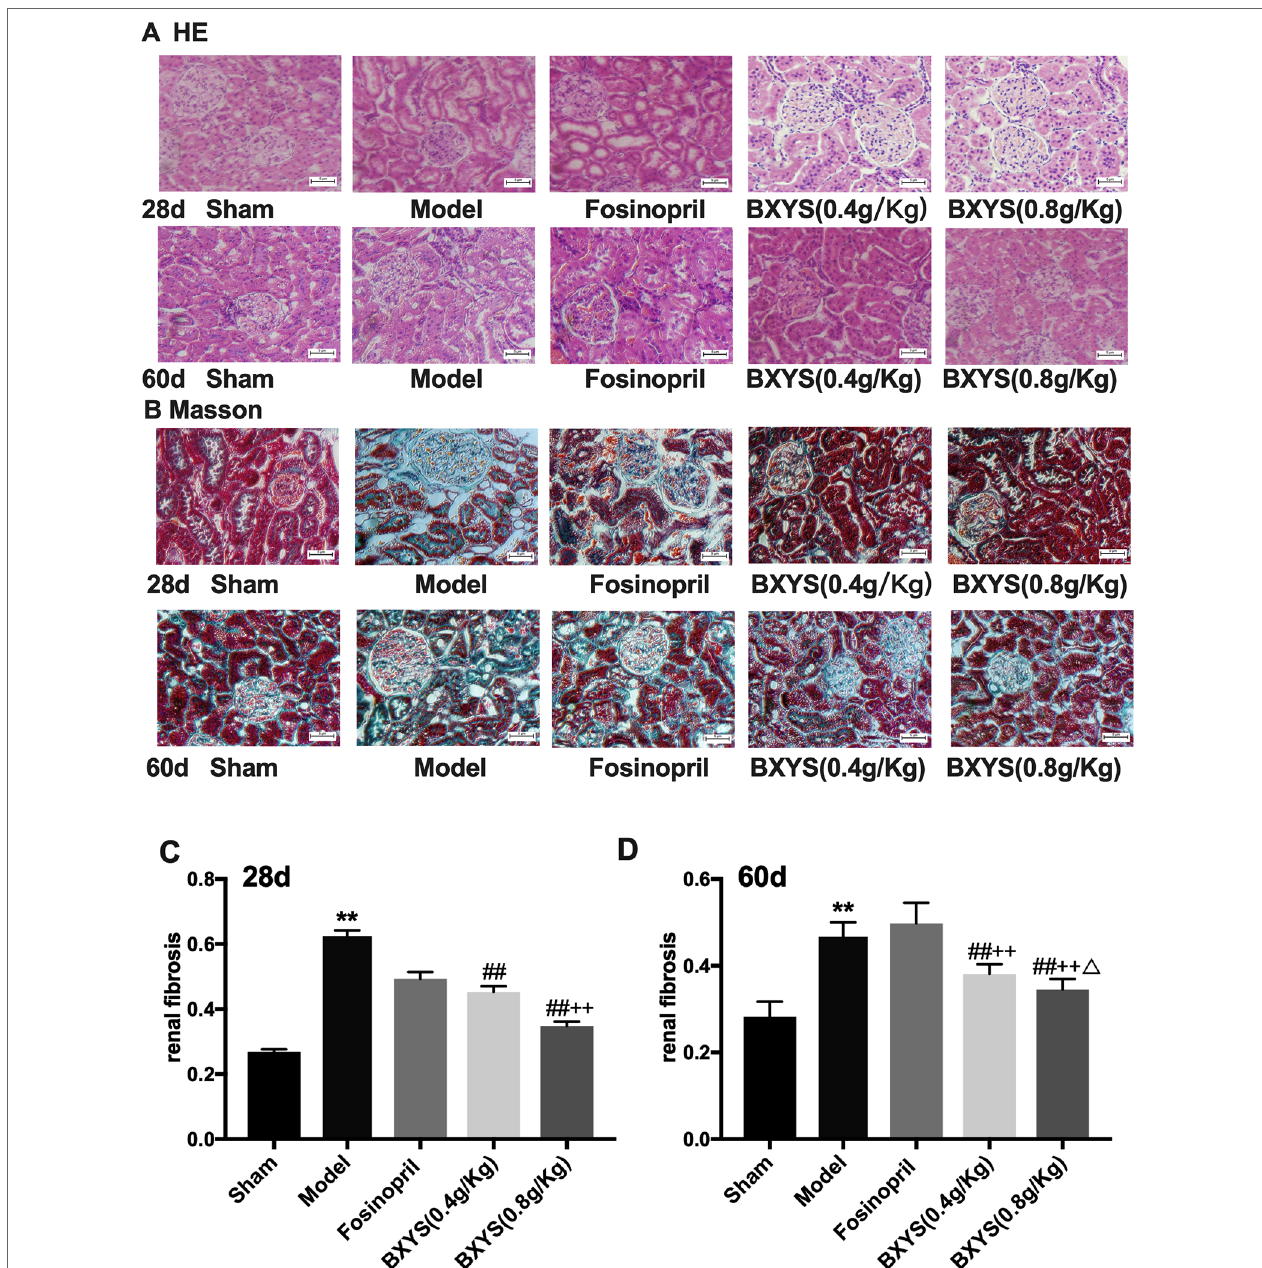
FIGURE 5 | Histological analysis after 28 days and 60 days of drug administration. Sham, sham group; Model, model group; Fosinopril, fosinopril group; BXYS (0.4 g/kg), Buxin Yishen 0.4 g/kg treated group; BXYS (0.8 g/kg), Buxin Yishen 0.8 g/kg treated group. **P < 0.01 vs. sham group. ## P < 0.01 vs. model group. ++ P < 0.01 vs. fosinopril group. Δ P < 0.05 vs. BXYS (0.4g/kg) group. (A) Tissue sections were deparaffinized and stained with hematoxylin-eosin staining (HE) (×200 magnification). (B) Tissue sections were stained by Masson’s trichrome reagent (×200 magnification). ( C and D ) Quantitation of renal fibrosis after 28 days and 60